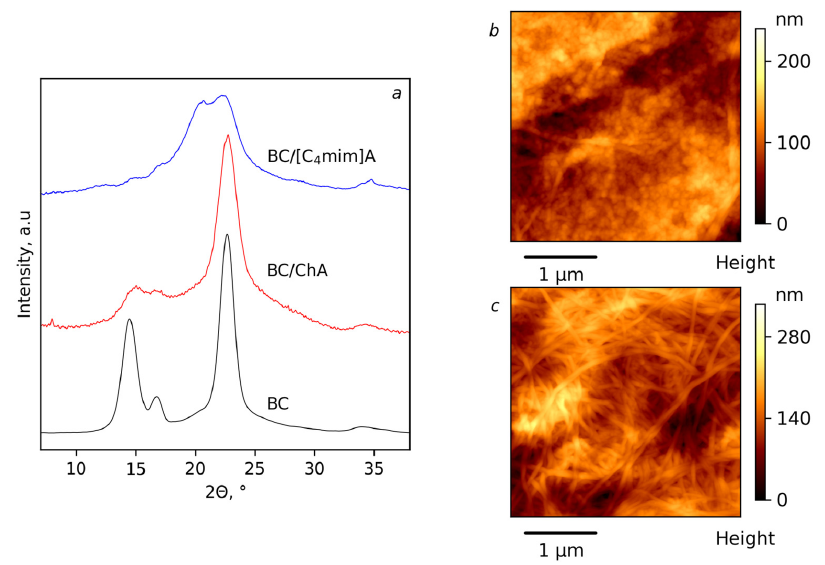
Figure 5. X-ray diffraction patterns obtained from BC samples ( a ), AFM images of BC/[C 4 mim]A ( b ), and BC/ChA ( c ).